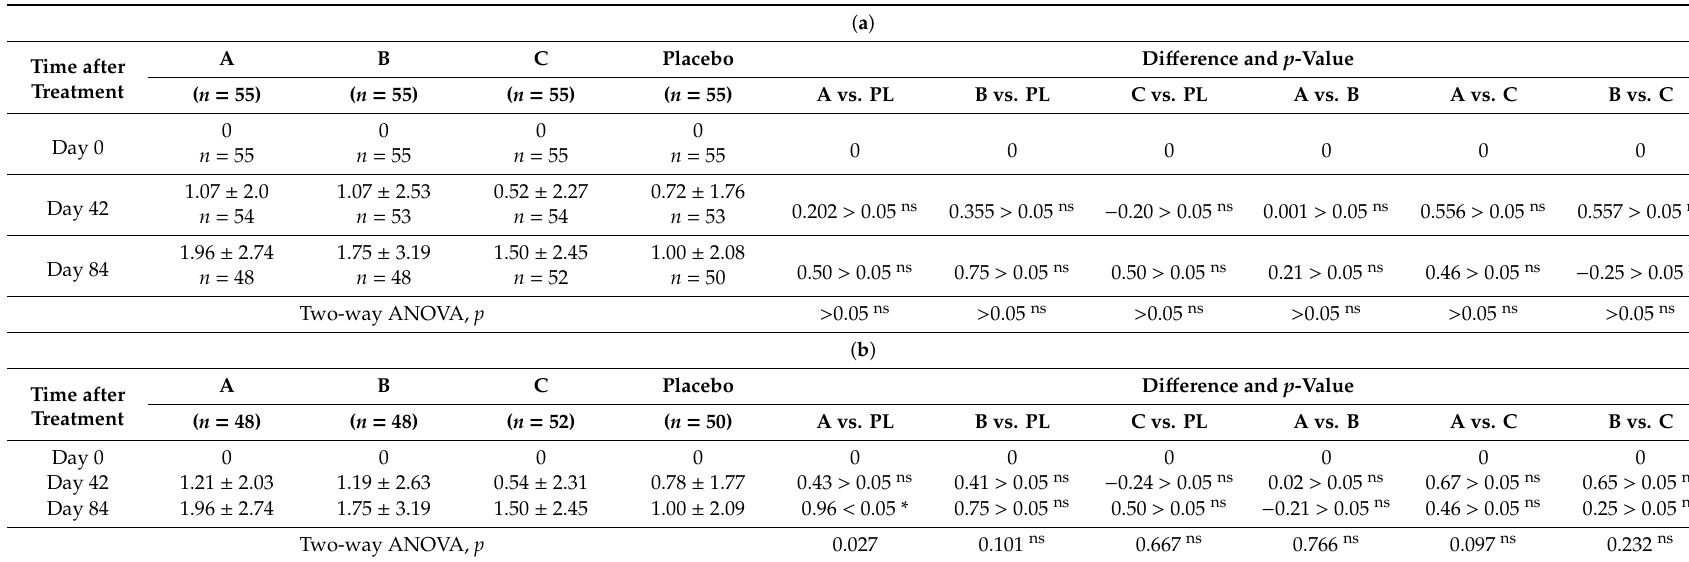
ns —not signoficant, *—significance p <